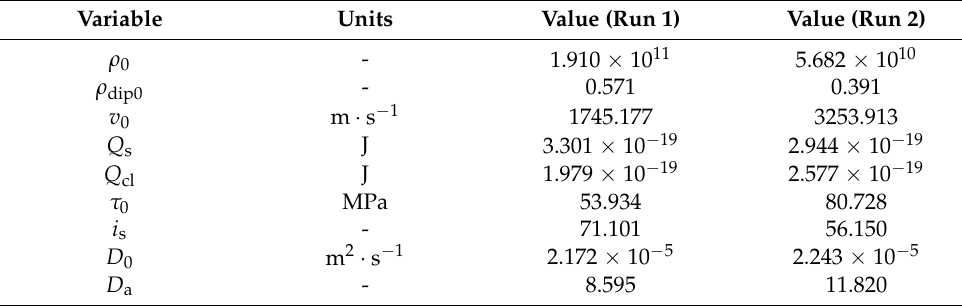
Table 9. The optimal parameters of the dislocation-density-based CP